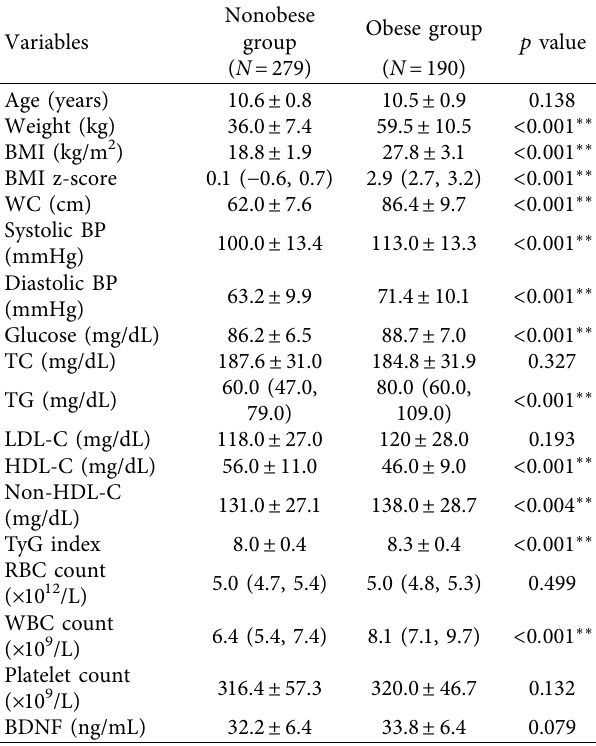
Table 1: Comparison of the anthropometric-cardiometabolic and hematological variables between nonobese and obese